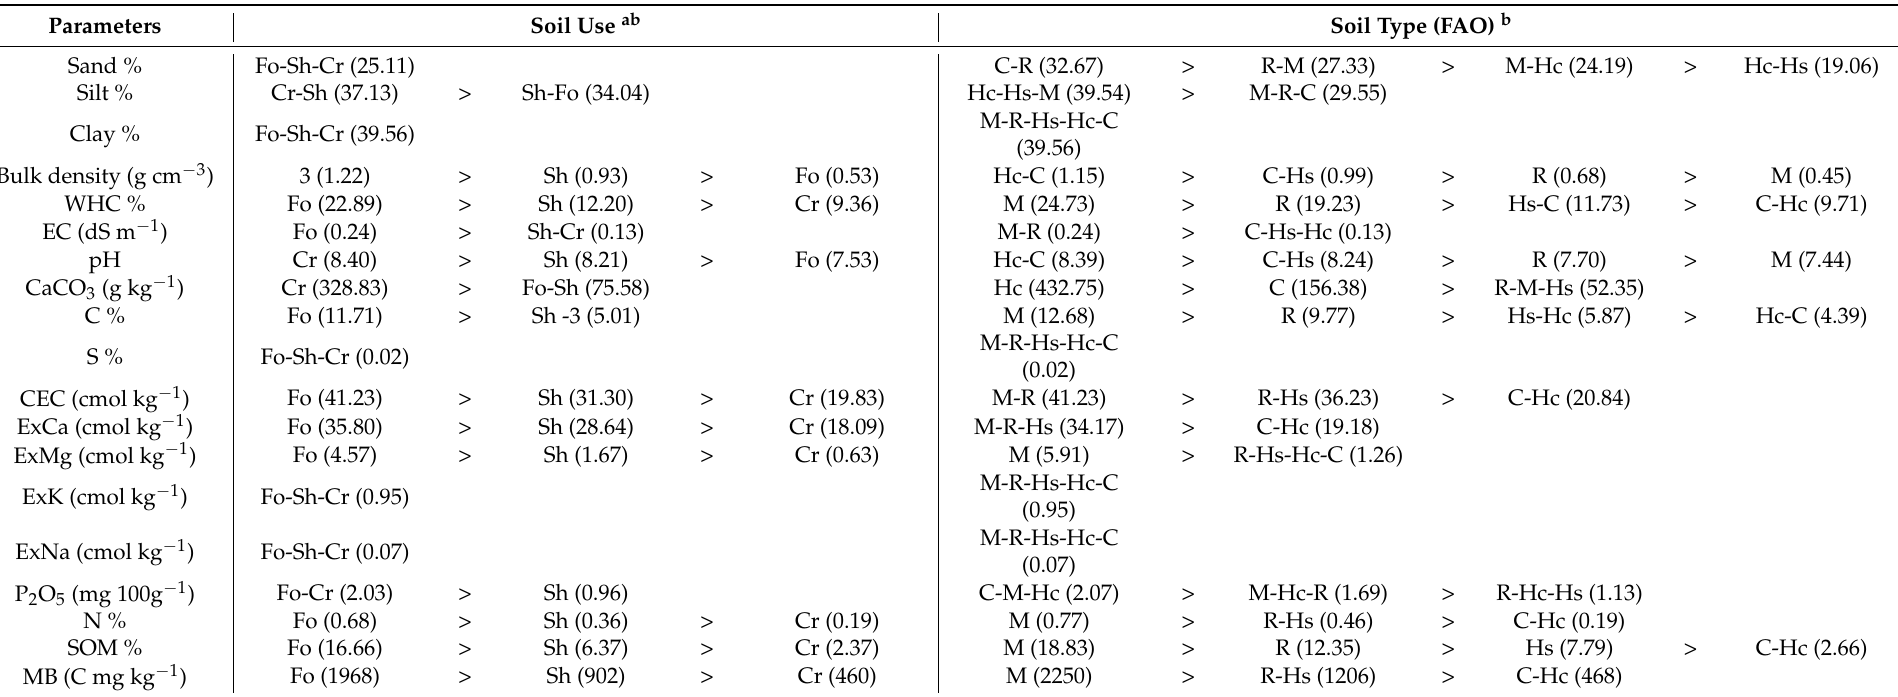
Table 3. Subgroups obtained in the ANOVAs Post hoc tests (Scheffe) based on soil use a or soil taxonomy b . Significant differences are considered at confidence level of 95% (alpha < 0.05). Numbers in brackets are the mean of subgroups. Groups are ordered from higher to lower means. Abbreviations as in Table